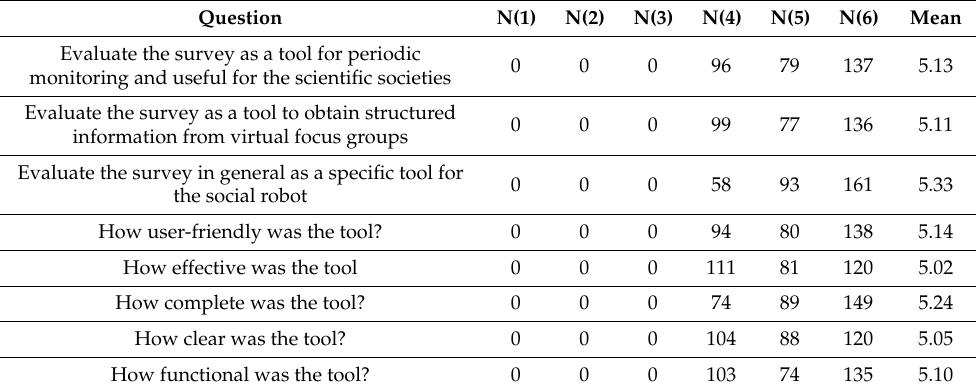
Table 4. Feedback form